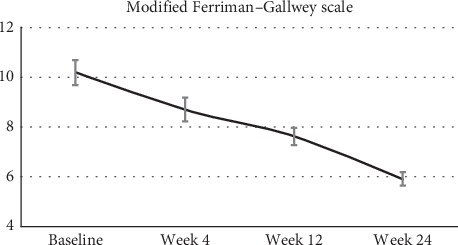
Modified Ferriman–Gallwey scale for scoring hirsutism (mFGHS). The data represent the mFGHS analysis made during each visit (baseline or week 0, week 4, week 12, and week 24). The error bars are average ± SEM.